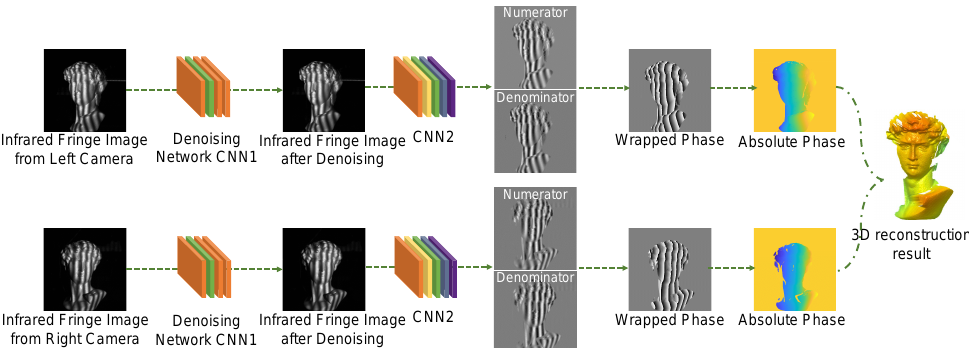
Figure 1. The flowchart of the proposed deep learning-based 3D measurements using NIR FPP. For CNN1, the input is the raw fringe image with speckle noise and the output is the denoised image. For CNN2, it learns to obtain the numerator and denominator. As the phase can be used as temporary texture, the 3D reconstruction is then calculated with stereo